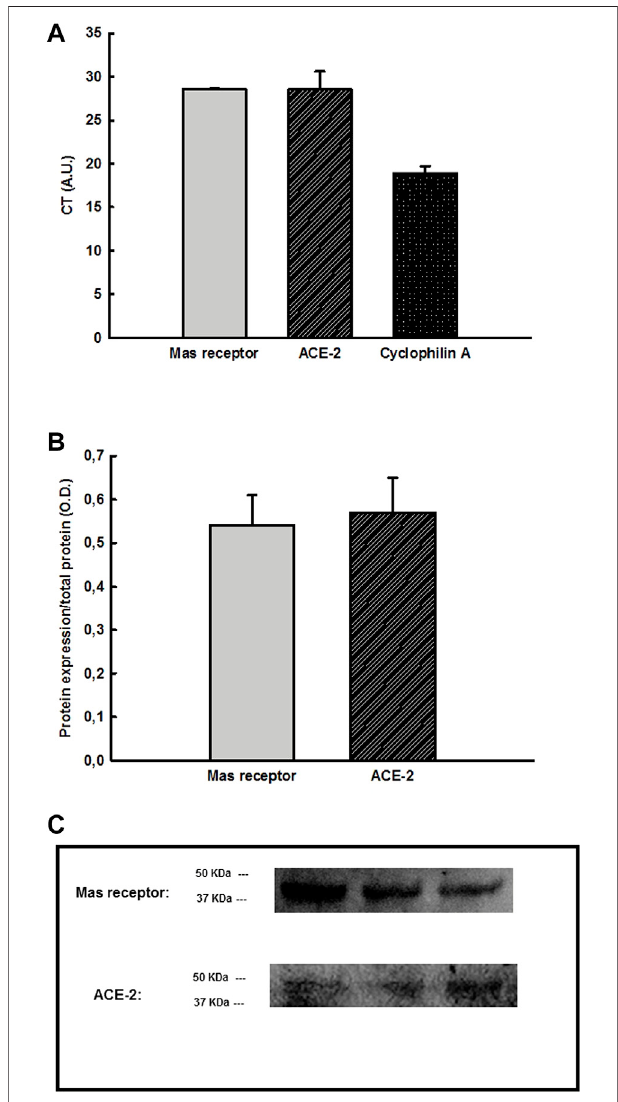
FIGURE 6 | (A) CT values obtained by qPCR showing the Mas receptors, ACE-2, and cyclophilin A (housekeeping gene) gene expression in the urinary bladder (UB) ( n = 6), (B) Mas receptors and ACE-2 protein expression normalized by total protein in the UB by western blotting assay ( n = 6), (C) Blots labeled for Mas receptors and ACE-2 in the UB samples by western blotting. Abbreviation: OD, Optical density.